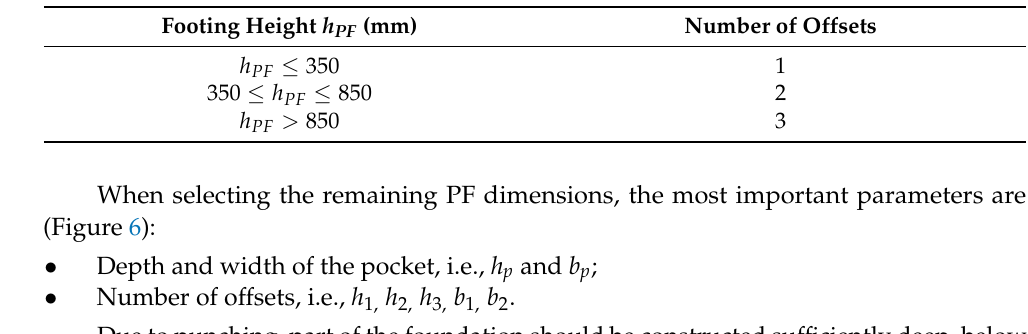
Figure 6. Monolithic PF structure with one (left side) and two offsets (right side); description in the text. Table 1. The number of offsets of PF depending on its h PF , adapted from Ref.